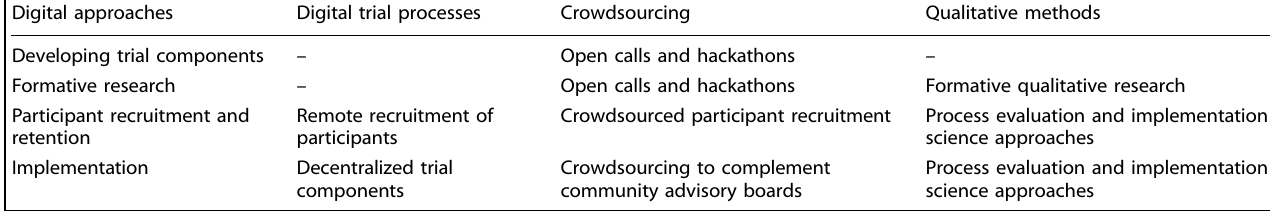
Table 1. Summary of digital approaches to community engagement and its application in the life course of clinical trials.